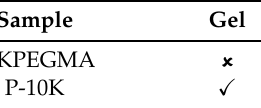
Figure 11. Polypseudorotaxanes inter- or intra-crosslink with each other via hydrogen bonding. Table 2. Ten percent 10KPEGMA and 10% P-10K solutions with 10% α -CD.